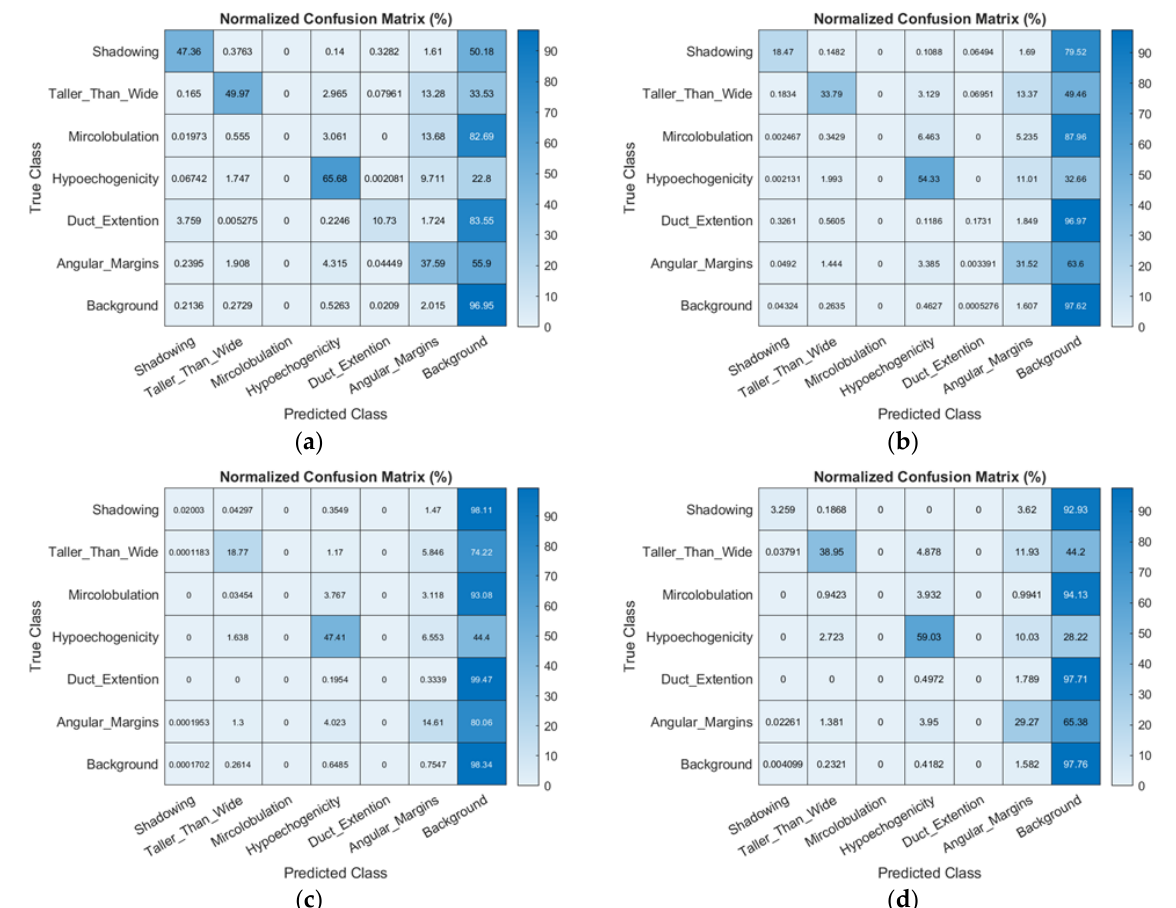
Figure 7. Normalised confusion matrix of the classification performance in DeepLab v3+ with the selected three decoders and FCN-32s, based on the selected six BI-RADS lexicons. The rate of correct recognition for each lexicon is shown in percentage. ( a ) Classification performance of DeepLab v3+ with ResNet-50; ( b ) classification performance of DeepLab v3+ with Inception-ResNet-v2; ( c ) classification performance of DeepLab v3+ with MobileNet-v2; ( d ) classification performance of the